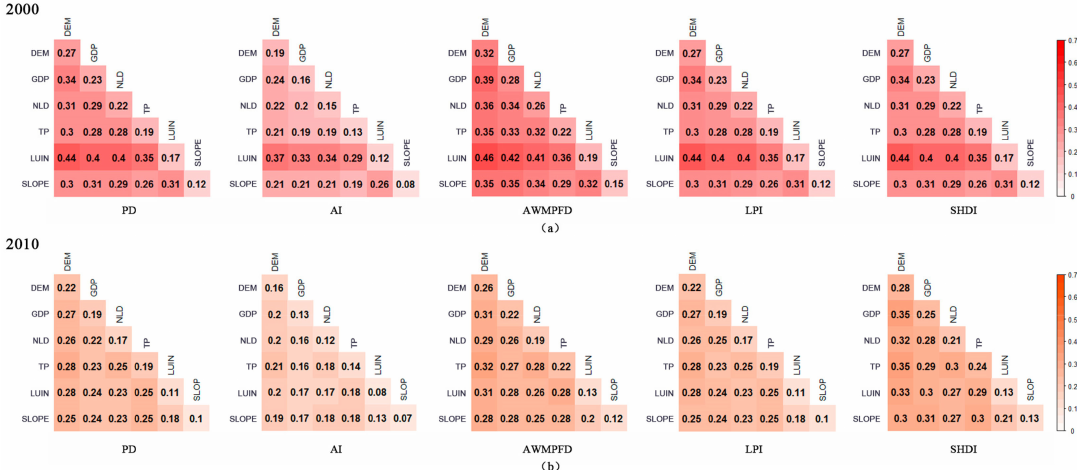
Figure 10. The force q among any two influencing factors on each landscape pattern metric interactively in ( a ) 2000 and ( b )